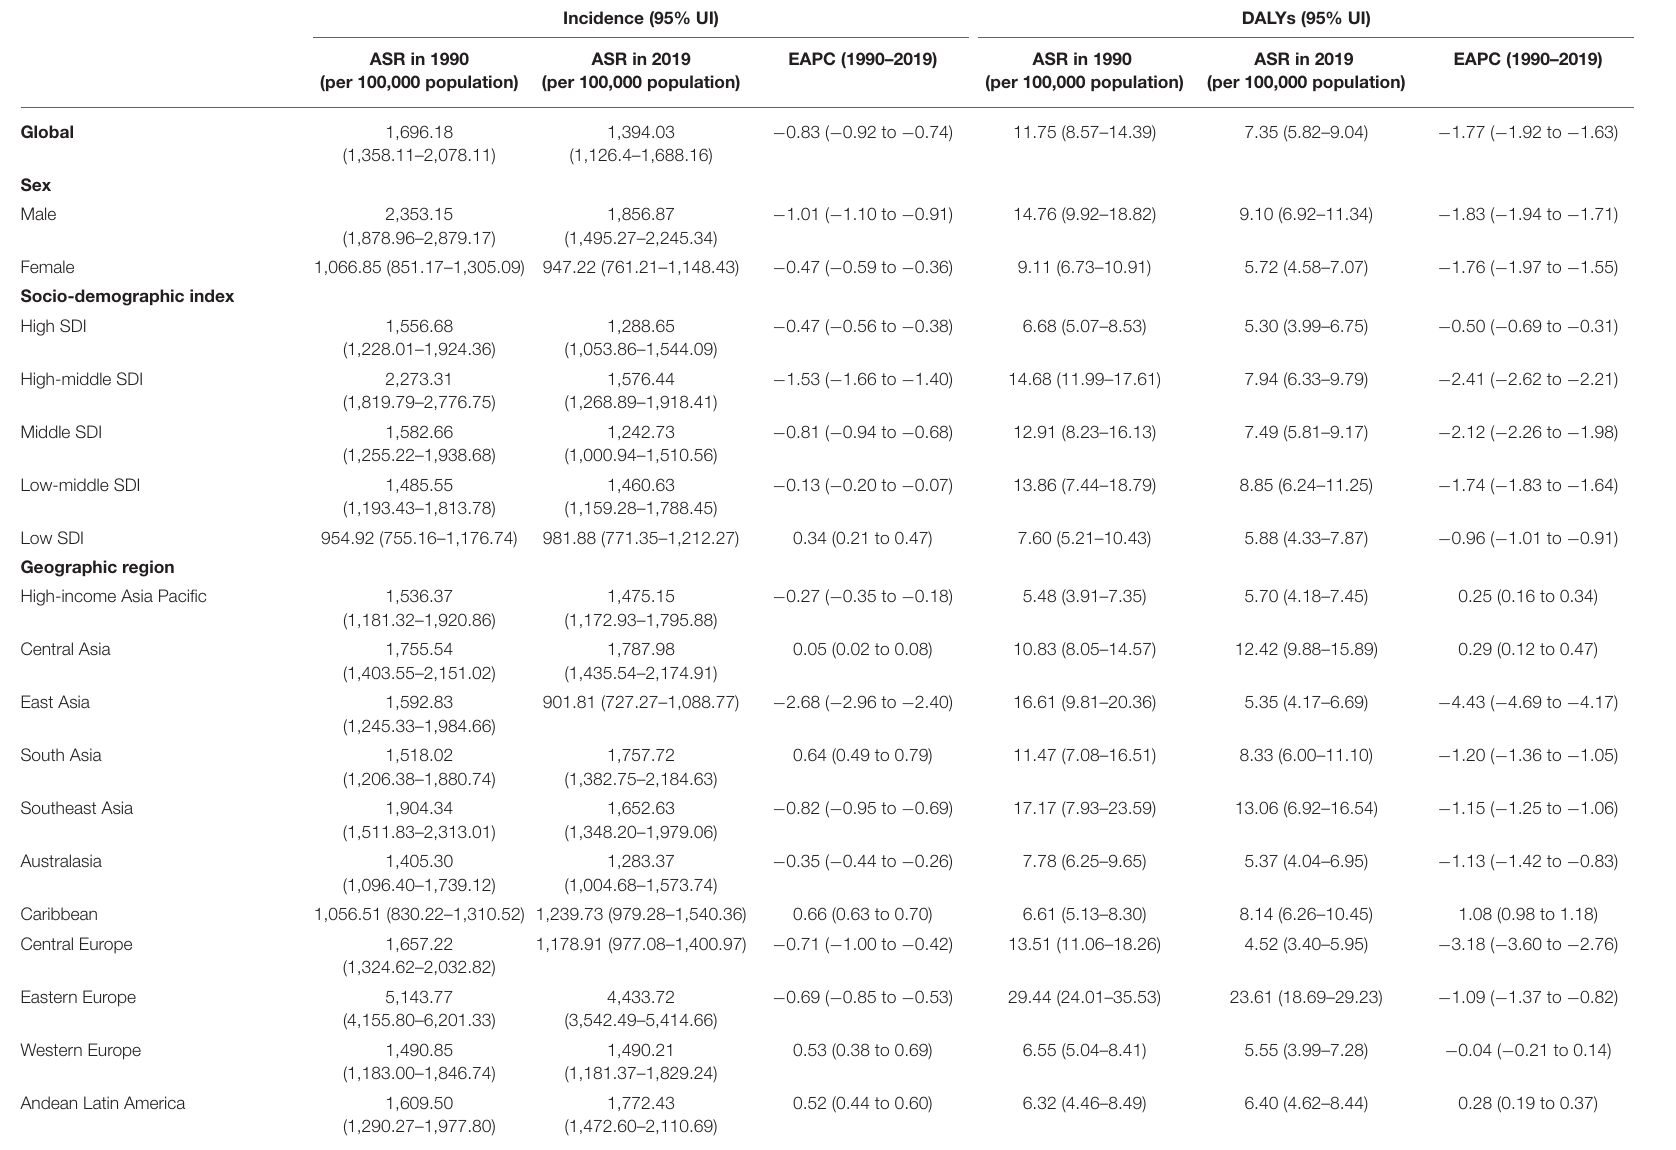
TABLE 1 | Age-standardized rates of incidence and disability-adjusted life years of urolithiasis in 2019 and their temporal trend from 1990 to 2019 at the global and regional